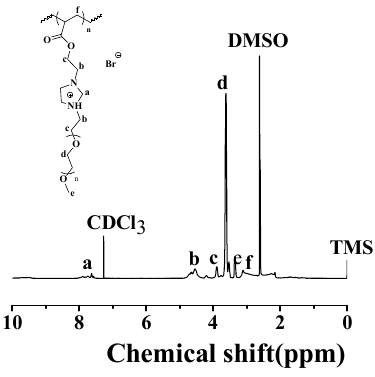
Figure 1. 1 H NMR spectrum of poly(ionic liquid) (PIL) with CDCl 3 and DMSO- d 6 as mixed solvents and tetramethylsilane (TMS) as an internal standard.